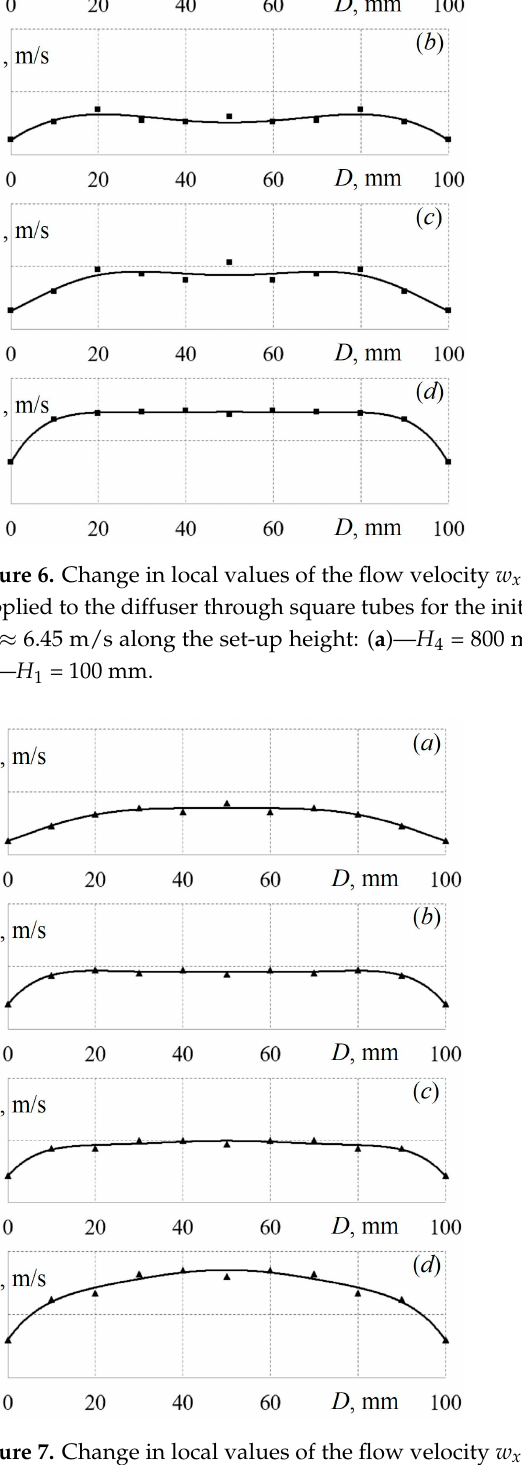
Figure 7. Change in local values of the flow velocity w x along the cylinder diameter D when air is supplied to the diffuser through triangular tubes for the initial average flow velocity in the first section w 1 ≈ 6.65 m/s along the set-up height: ( a )— H 4 = 800 mm; ( b )— H 3 = 500 mm; ( c )— H 2 = 300 mm; ( d )— H 1 = 100